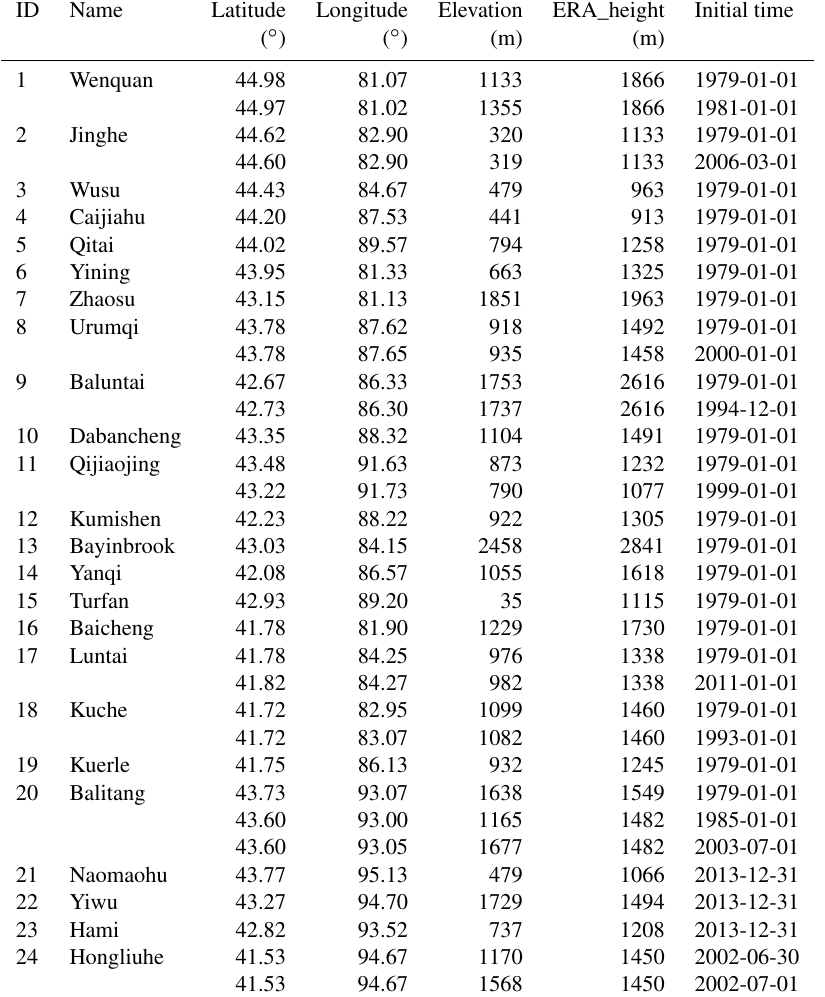
Table 1. Test sites information (ERA_height is the ERA-Interim grid height). The date format is year-month-day.